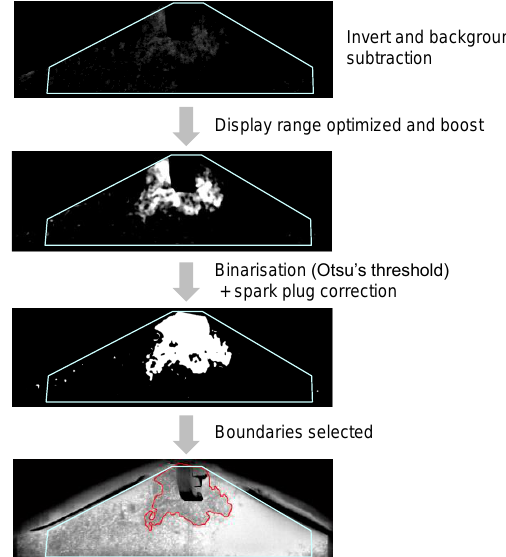
Figure 8. Image processing steps to extract the flame front from the high-speed PIV image.